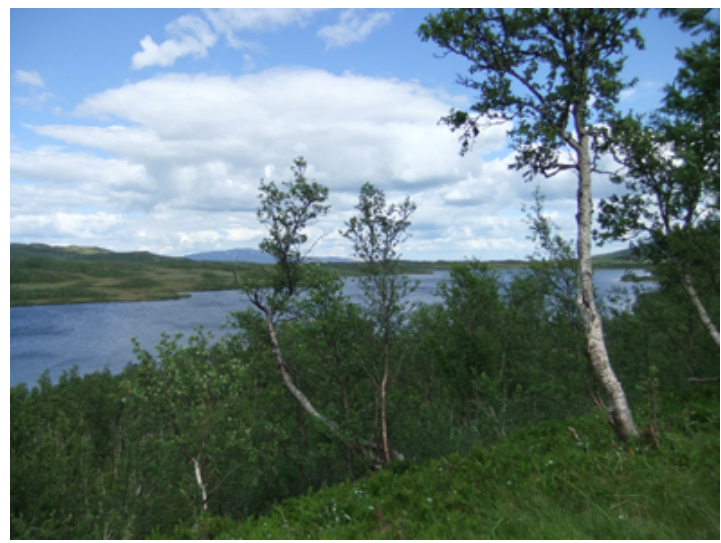
Figure 2. Experimental group picture used in Study